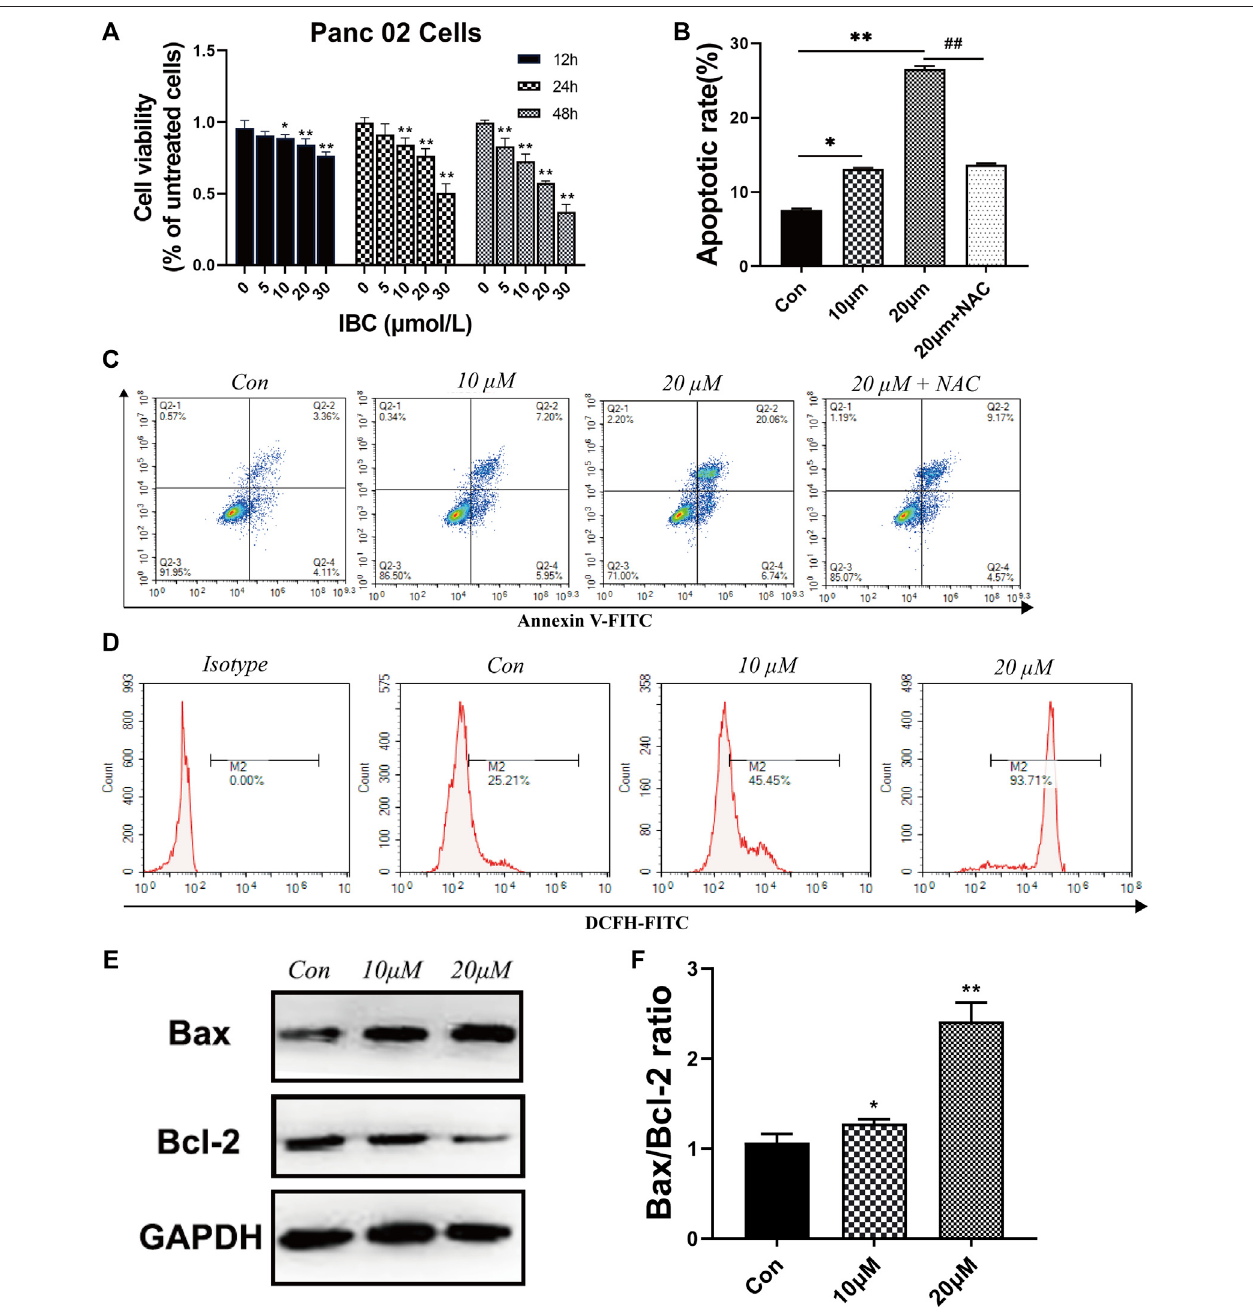
FIGURE 7 | IBC exerted the effects of inhibiting proliferation and promoting apoptosis. (A) CCK8 assays of Panc 02 cells after treatment with IBC (1 μ M, 5 μ M, 10 μ M,15Mm, 20 μ M,and30 μ M)for12,24,and48 h;* p < 0.05and** p < 0.001,versusthecontrolgroup. (B-C) Thestaticcellapoptosisratesweredetected by fl ow cytometry ( N =3). Therepresentative imageisreported.The columnsrepresentthemean ±SEM.Student ’ sttest wasapplied toanalyzethe data,* p < 0.05** p < 0.001 versusthecontrol. (D) Flowcytometryimagesand fl uorescenceintensityofROSstaining( N =3).Therepresentativeimageisreported. (E,F) Westernblotresultsof Bax, Bcl-2, and GAPDH after being treated with 10 μ M and 20 μ M. The columns represent the mean ± SEM, * p < 0.05 ** p < 0.001, versus the control group.